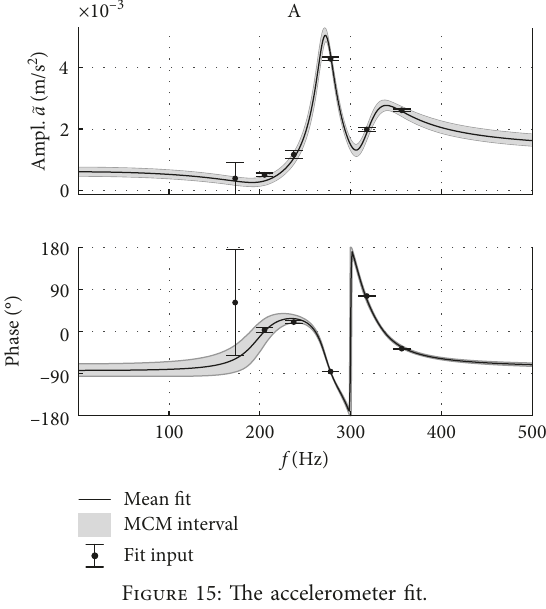
Figure 15: The accelerometer fit.